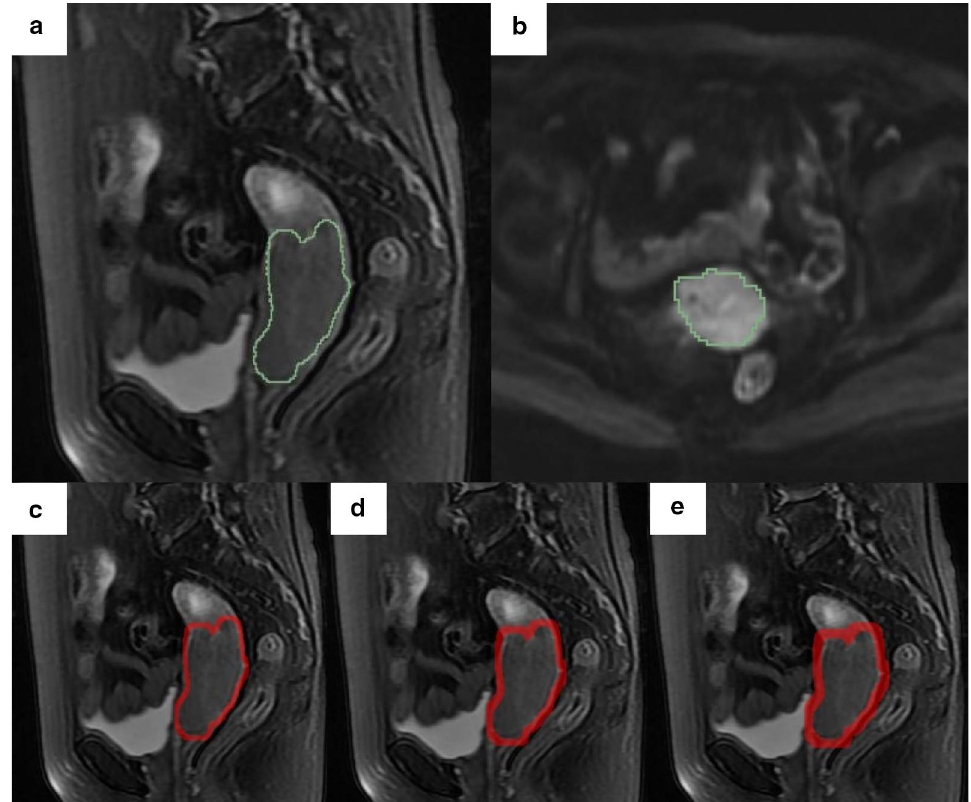
Fig. 2 The intra- and peritumoral ROIs in this study. a is on sagittal T2WI; b is on DWI. The green line represents the boundary of the tumor; c - e are the example (3, 5, 7 mm expansion dimension) of the dilated MRI with various radial dilation distances outside the original masks in the MRI. The red rings indicate the peritumoral